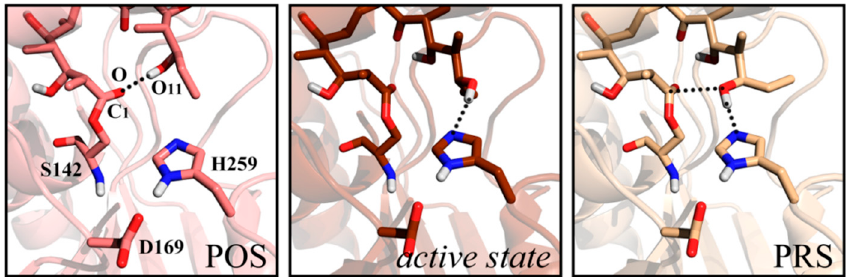
Figure 1. Structures of pre-organization state (POS), active state and the pre-reaction state (PRS) of 6-deoxyerythronolide B synthase (DEBS) thioesterase (TE) system.